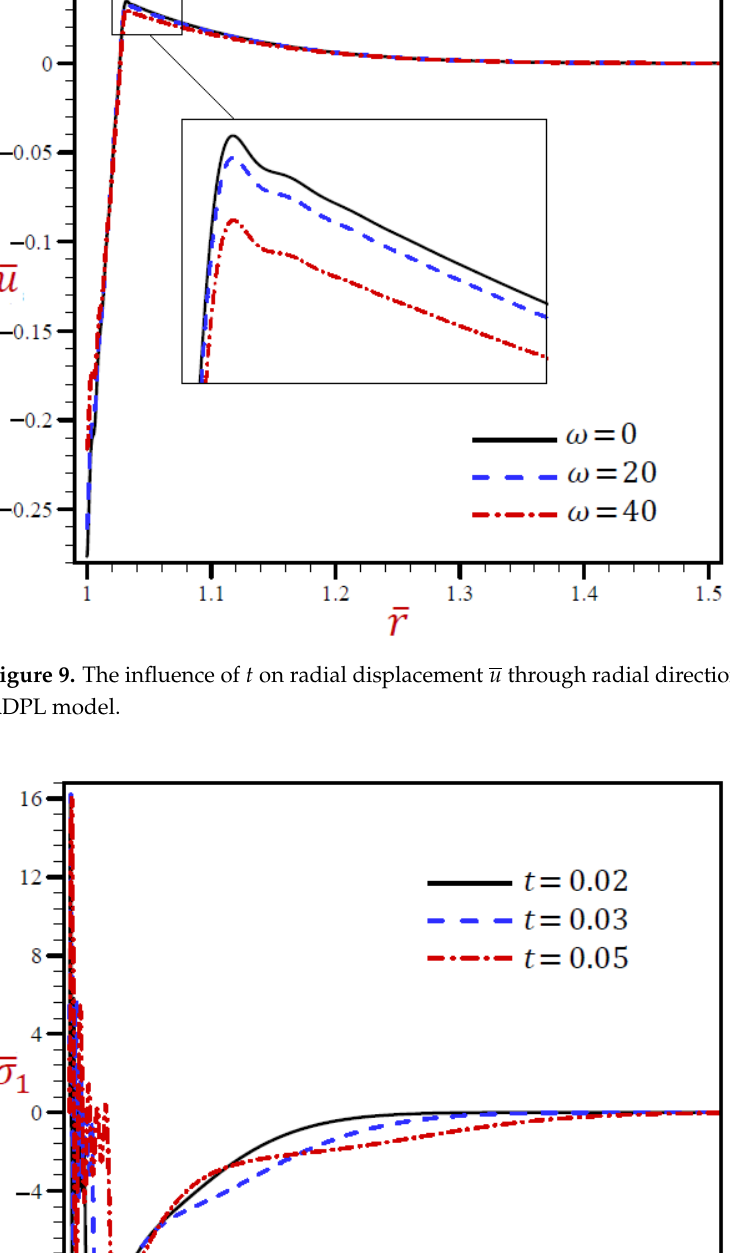
Figure 8. The influence of 𝑡 on volumetric strain 𝑒̅ through radial direction of spherical hole using RDPL model.